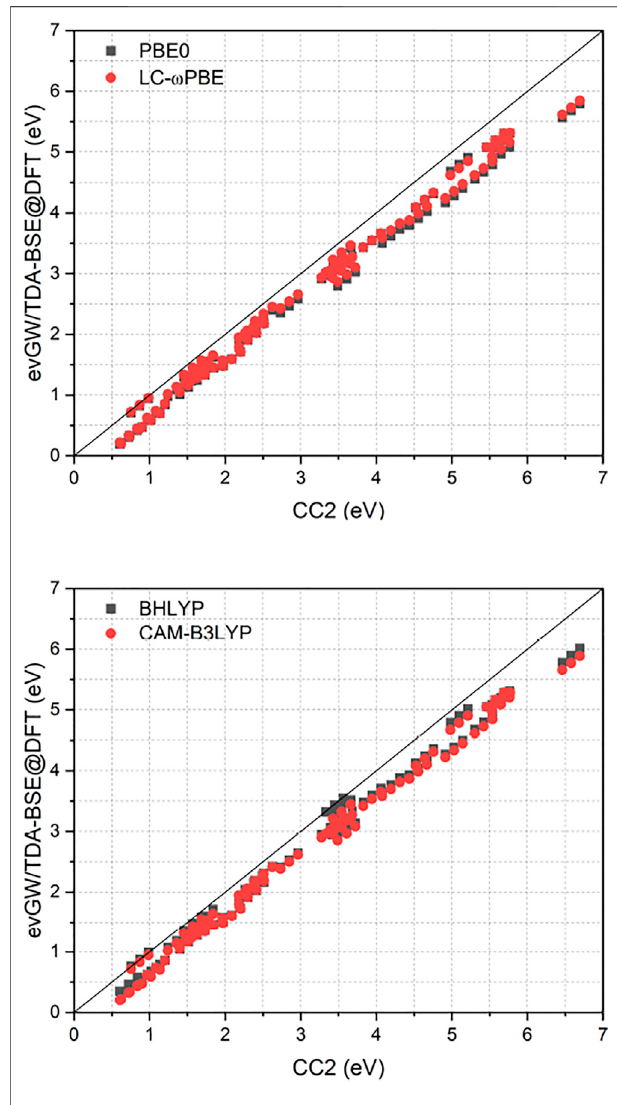
FIGURE 2 | Comparison of excitation energies from the RI-CC2 and ev GW /TDA-BSE@DFT methods. ev GW /BSE calculations have been performed using either PBE0 or LC- ω PBE spinors. All calculations used the def2-TZVP basis set. All values in